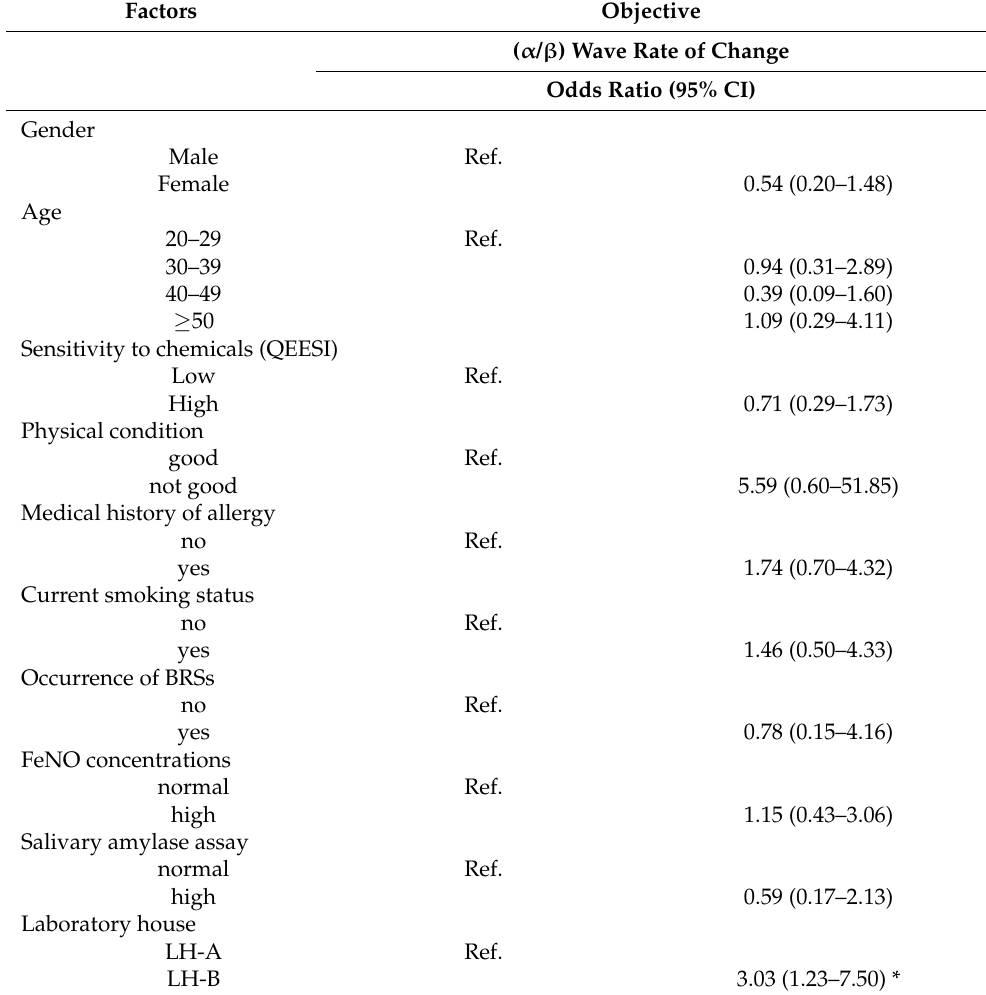
Table 5. Results of logistic regression on the associations between objective evaluation and personal and environmental